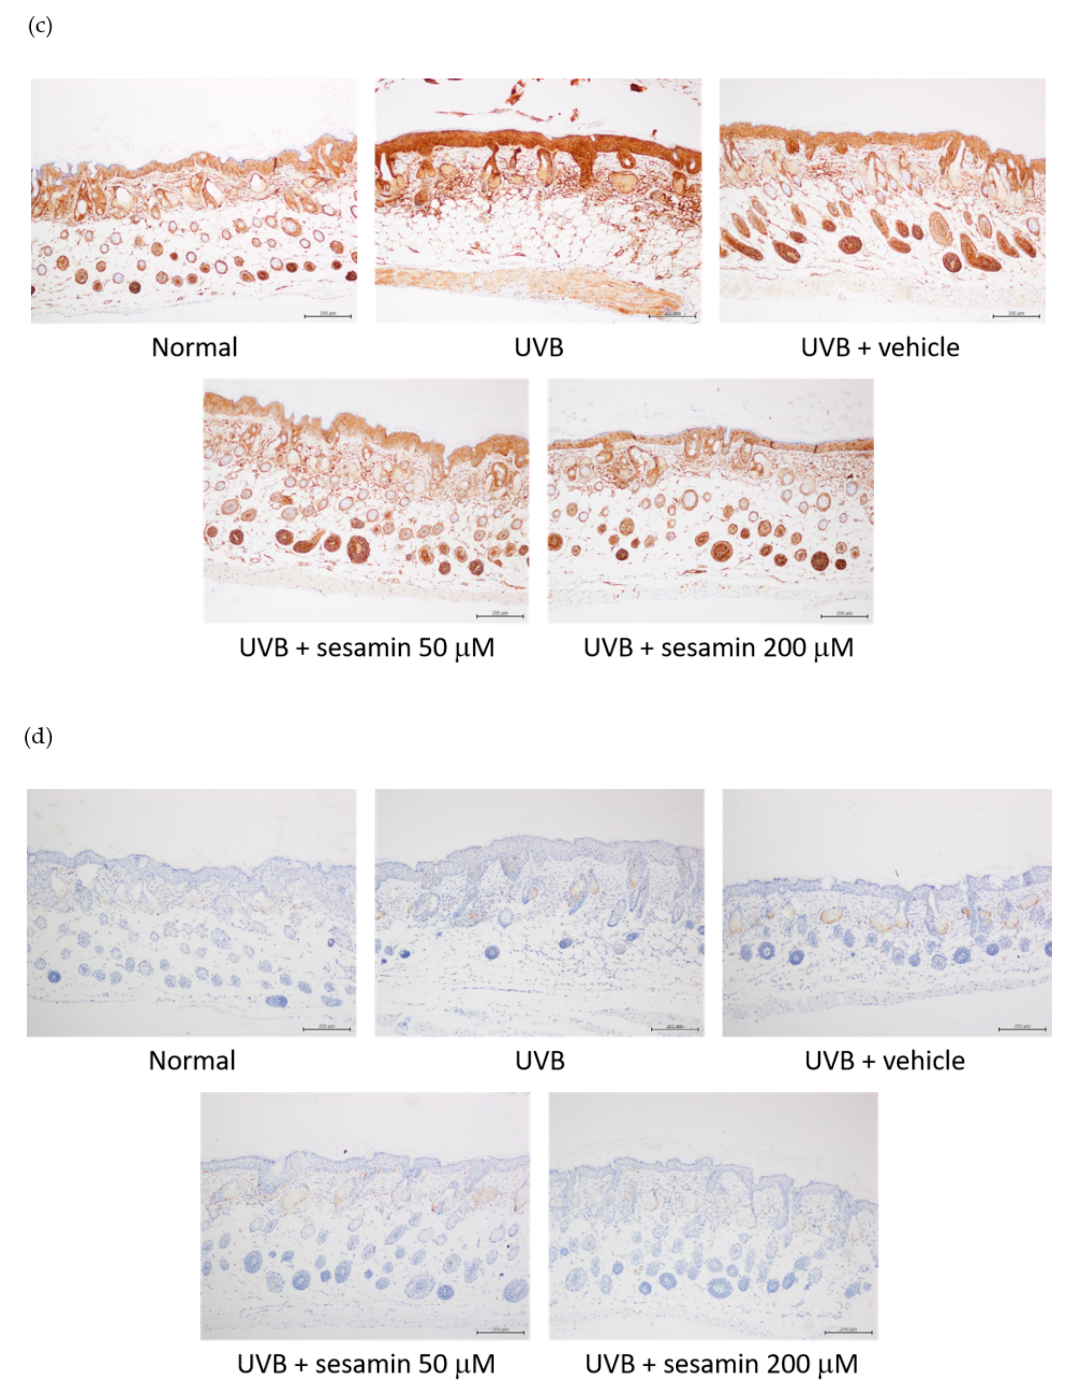
Figure 18. Immunohistological staining of skin slices for ( a ) MMP-1, ( b ) IL-6, ( c ) NF- κ B, and ( d ) i-NOS in the hairless mouse skin after chronic UVB exposure and sesamin treatment.